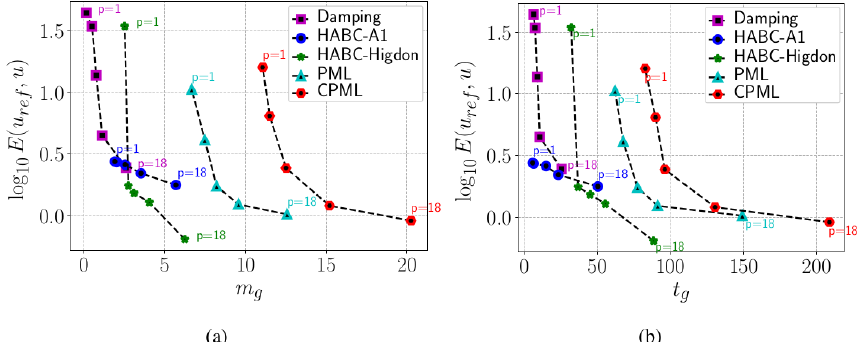
Figure 14. Analyses of log 10 E(u ref ,u) × m g (a) and log 10 E(u ref ,u) × t g (b) . The measures are related to the execution of the forward solver. The velocity model was part of the Marmousi, with the settings shown in Table 1 and the peak of frequency as f 0 = 5Hz.